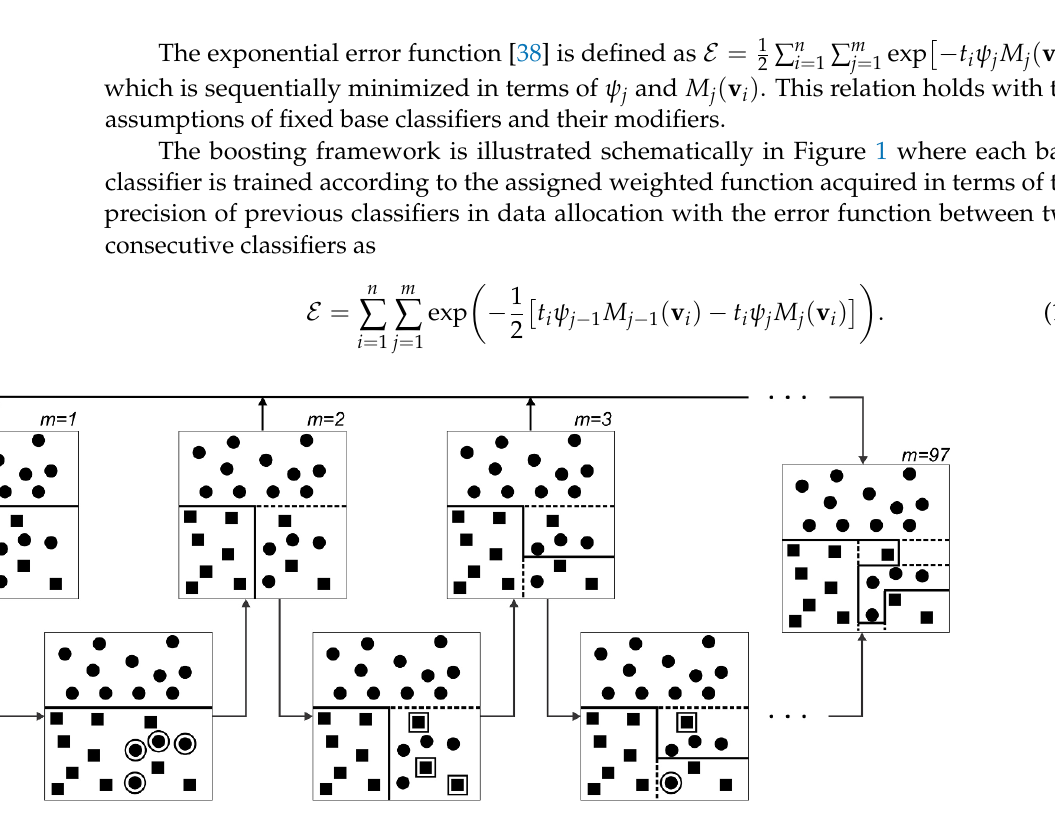
Figure 1. Demonstration of adaptive boosting technique where base classifiers with simple thresholds are trained according to the assigned weighted function acquired relative to the precision of the previous classifier in data allocation. Each sample shows the number of classifiers, m , trained up to that point. The solid and dashed lines in the domains are the decision made and revised choices, respectively, based on the weight of the misplaced data illustrated with expanded